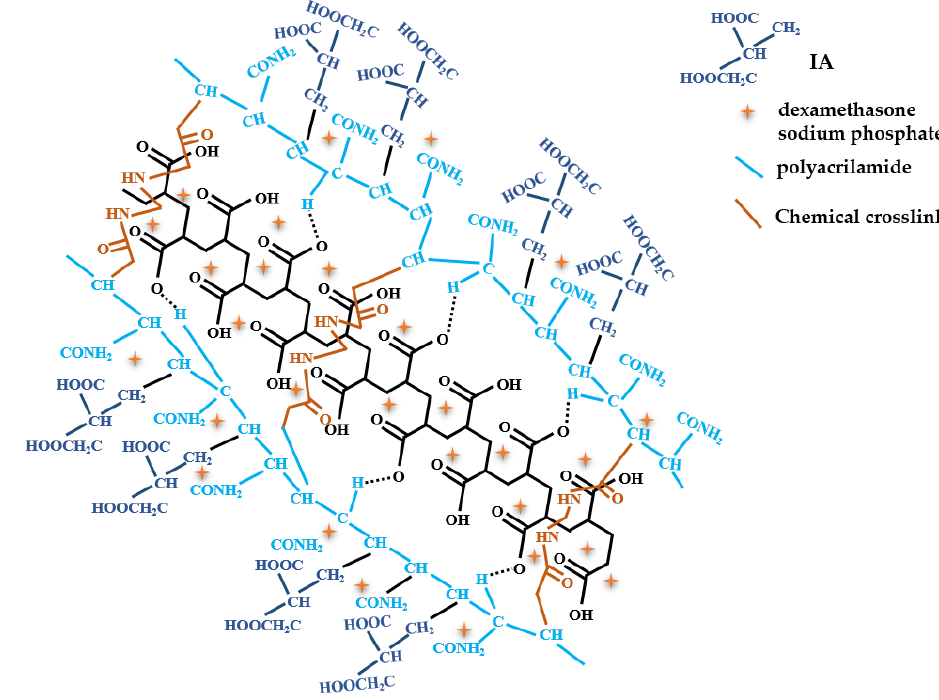
Figure 7. IA-grafted-poly(acrylamide)/carbopol hydrogel compound (adapted after [142]). This type of hydrogel is effective in targeted and controlled drug